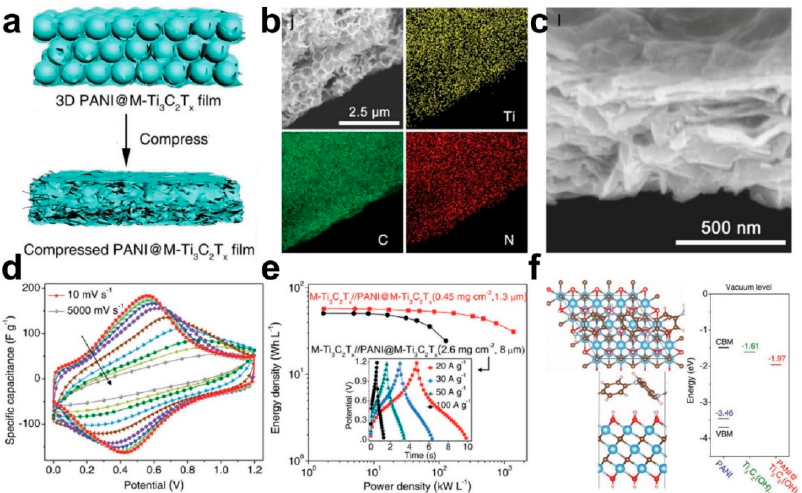
Figure 3. PANI@M-Ti 3 C 2 T x electrode materials with 3D structure. ( a ) Schematic diagram showing